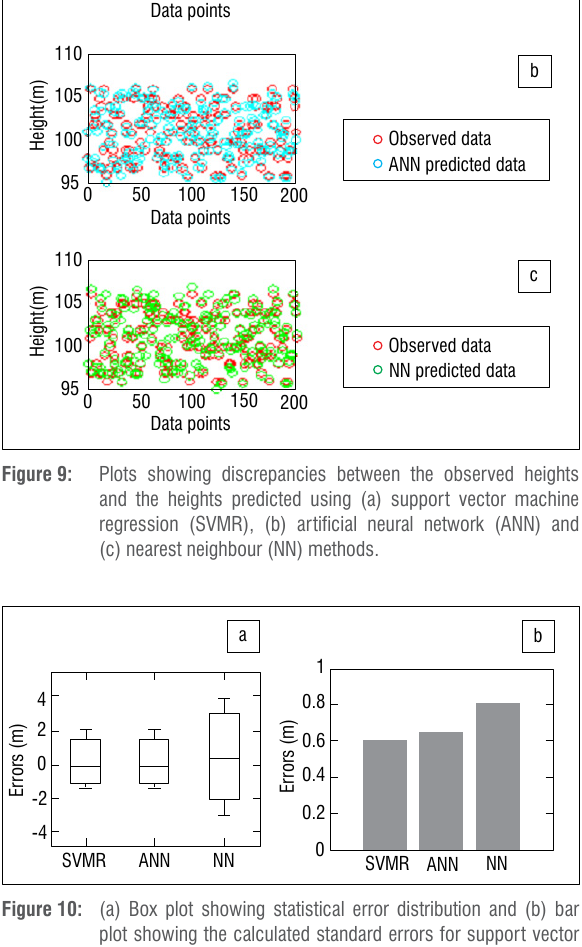
Figure 10: (a) Box plot showing statistical error distribution and (b) bar plot showing the calculated standard errors for support vector machine regression (SVMR), artificial neural network (ANN) and nearest neighbour (NN)